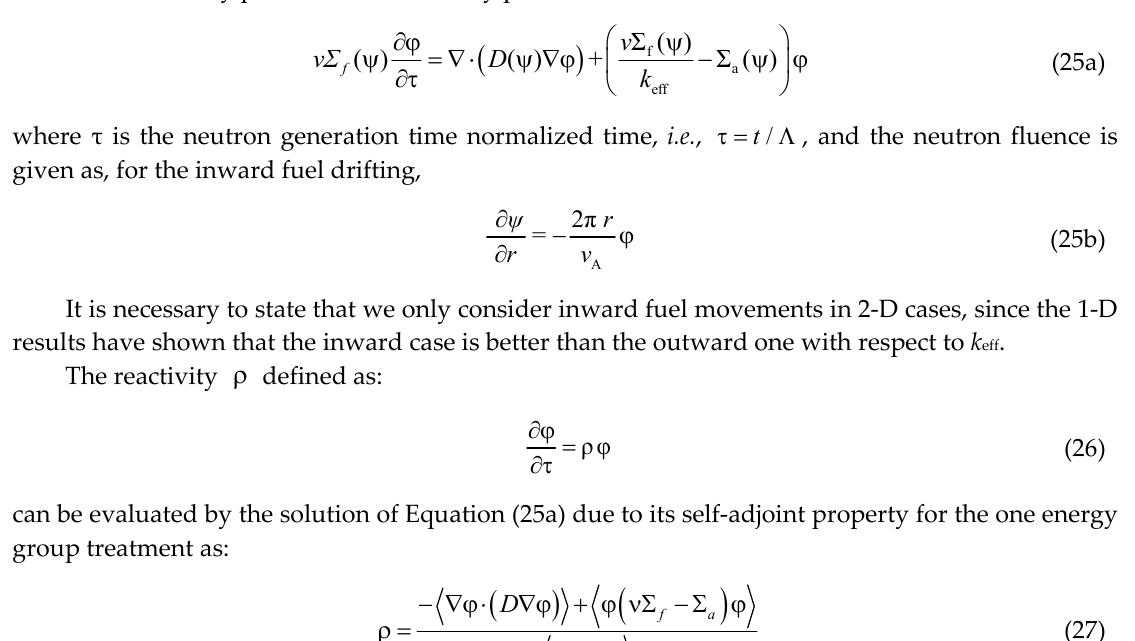
Figure 7. Macroscopic cross sections of